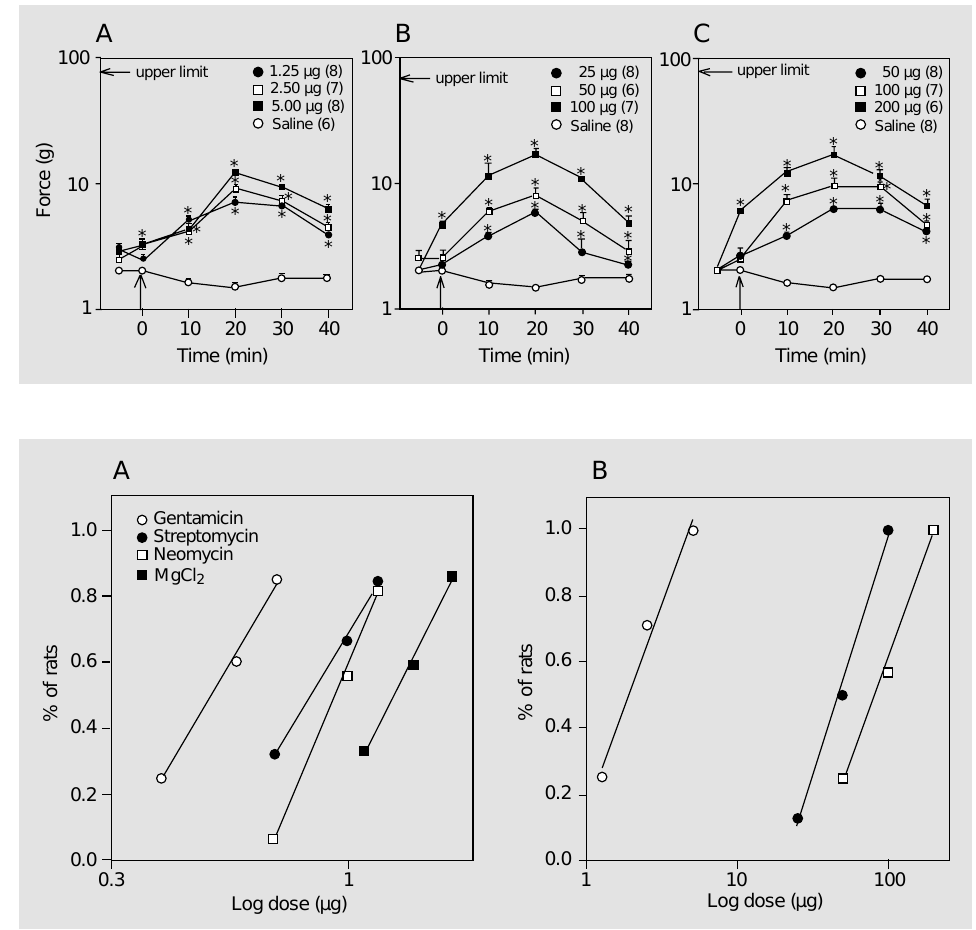
Figure 2. Time course of the ef- fects of intrathecal administra- tion (vertical arrow) of gentami- cin (A), streptomycin (B) and neomycin (C) on the incisional paw withdrawal threshold to mechanical stimuli in rats. The upper limit (horizontal arrow) rep- resenting the maximum force (75.858 g) used in the test is indicated in the upper left cor- ner. Points are means ± SEM. Doses and number of rats are indicated in the upper right cor- ner. *P<0.05 compared to sa- line (Mann-Whitney test).